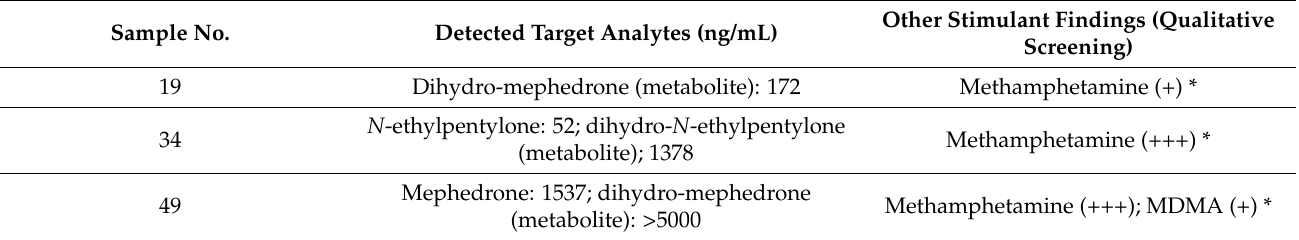
Table 5. Findings from analysis of authentic urine